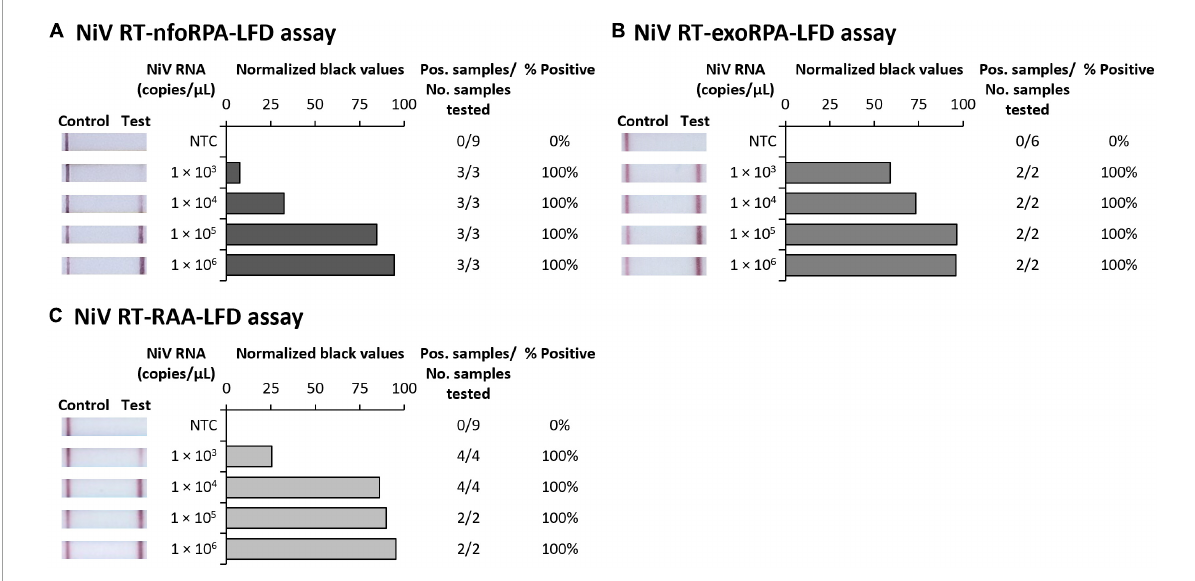
FIGURE1 Analytical sensitivities of three Nipah virus recombinase-based isothermal amplification lateral flow detection assays with RNA transcripts. Sensitivity testing used Nucleoprotein (N) gene fragment RNA transcripts diluted 10-fold in water for RT-nfoRPA-LFD (A) , RT-exoRPA-LFD (B) , and RT-RAA-LFD (C) . Images of lateral flow strips with two bands (control and test band) indicates the sample is positive for NiV synthetic RNA transcript, and single control band indicates a valid reaction with negative sample. Photograph of lateral flow strips with control bands (all samples) and test bands (positive samples) compared to copy number of serially diluted NiV RNA (copies/ µ L) and no template control (NTC) (left). Normalized pixel density (normalized black values) from the lateral flow test strip displayed (middle). Positive samples compared to number of samples tested at that dilution was used to calculate the percentage of positive tests performed at that dilution